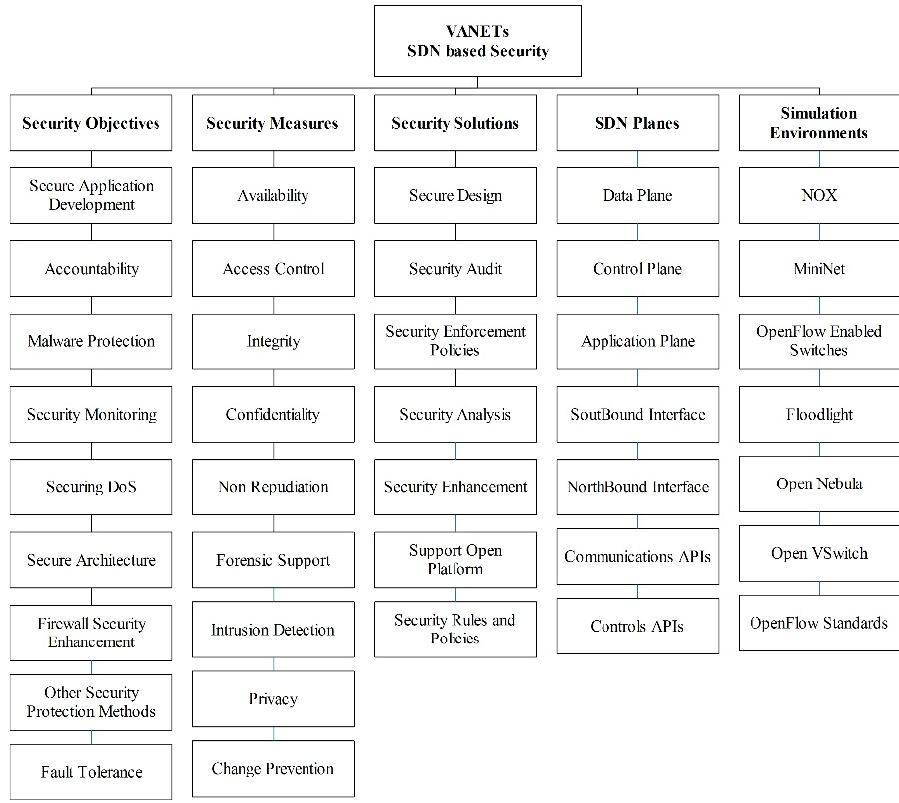
Figure 10. SDN security taxonomy.